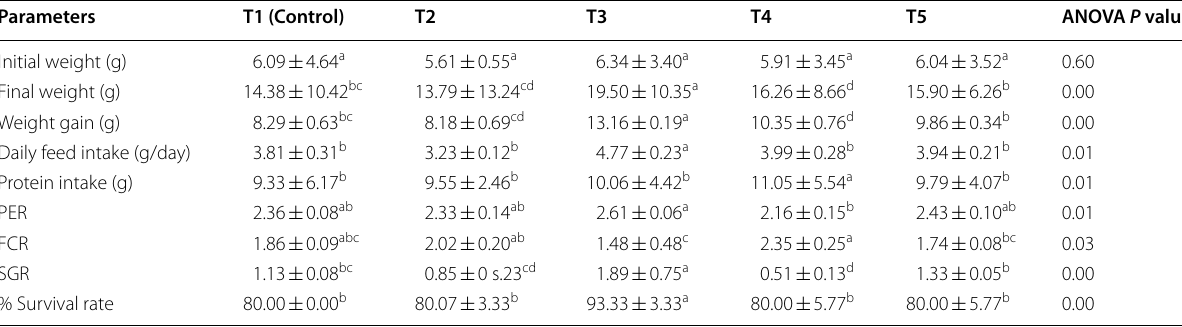
Figures in each row having the same superscripts are not significantly different ( P > 0.05) Mean in a given row with the same letter a, b, c, d or e were not significantly different at ( P > 0.05)